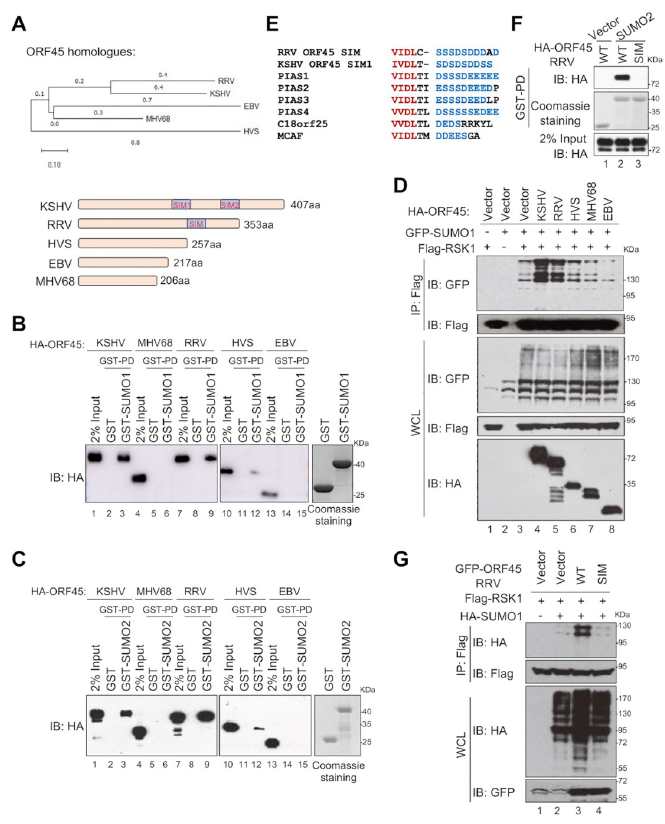
Fig 5. The SUMO E3 ligase activity is conserved in ORF45 of RRV. ( A ) Phylogenetic tree of the indicated γ - herpesviruses based on their ORF45 sequence. Scale: 0.1 (upper panel). Schematic diagram for ORF45 homologues (lower panel). ( B-C ) The interaction between ORF45 homologues and SUMO1 (B) or SUMO2 (C). GST only, GST-SUMO1, or GST-SUMO2 were mixed with the cell lysates from HEK293T transfected with ORF45 KSHV , ORF45 RRV , ORF45 HVS , ORF45 EBV , or ORF45 MHV68 for 30 min and the mixture was subjected to GST pull-down assay. ( D ) The effects of ORF45 homologues on RSK1 SUMOylation. HEK293T cells were transfected with indicated plasmids and cell lysates were subjected to denatured IP and IB with indicated antibodies at 48 h post-transfection. ( E ) RRV ORF45 only contains one SIM. Alignment between ORF45 RRV SIM and well-characterized SIMs from indicated genes. Red: core sequence; Blue: acidic amino acid tail. ( F ) SIM mutation abolished RRV ORF45-SUMO2 interaction. ( G ) SIM mutation abrogated RRV ORF45-mediated RSK1 SUMOylation.